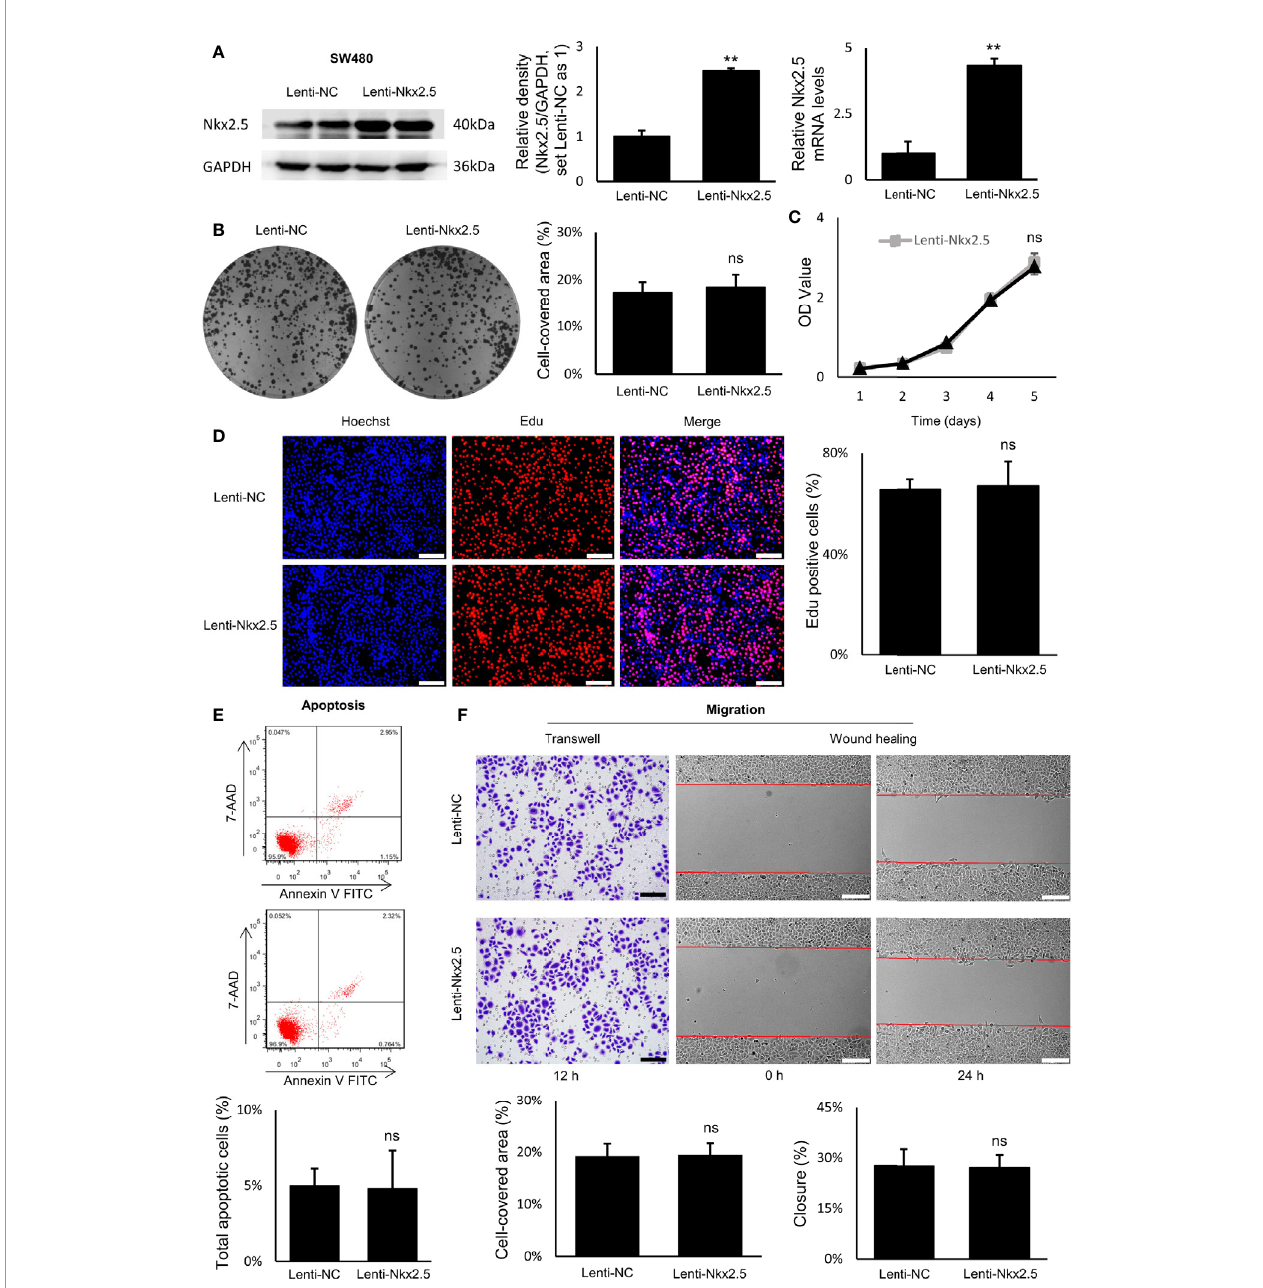
FIGURE 5 | Proliferation, apoptosis, and migration were not affected by Nkx2.5 overexpression in SW480 cells. (A) Detection of the protein and mRNA levels of Nkx2.5 in the Lenti-NC and Lenti-Nkx2.5 SW480 cells by Western blotting and RT-qPCR. GAPDH was used as an endogenous control gene. (B) Representative photographs of colony formation of the Lenti-NC and Lenti-Nkx2.5 SW480 cells. Cell-covered area of colonies was quanti fi ed and shown as percentage (%) relative to area of the well bottom. (C) Cell growth of the Lenti-NC and Lenti-Nkx2.5 SW480 cells was determined by MTT assay at each time- point. (D) Representative pro fi les for EdU cell proliferation assay of the Lenti-NC and Lenti-Nkx2.5 SW480 cells. Representative photographs were taken at magni fi cation of 200×. Scale bar (white) is 100- m m. (E) Apoptosis of Lenti-NC and Lenti-Nkx2.5 SW480 cells was measured by fl ow cytometry. Representative histograms show cell population in apoptotic (top right and bottom right quadrants), viable (bottom left quadrant), and necrotic (top left quadrant) states. (F) Cell migration was assessed by Transwell ® assay and wound-healing assay. Representative photographs were taken at magni fi cations of 200× and 100× for Transwell ® assay and wound-healing assay, respectively. Scale bar (black) is 100- m m. Scale bar (white) is 200- m m. ** represents P < 0.01; ns represents P ≥ 0.05 (no statistical signi fi